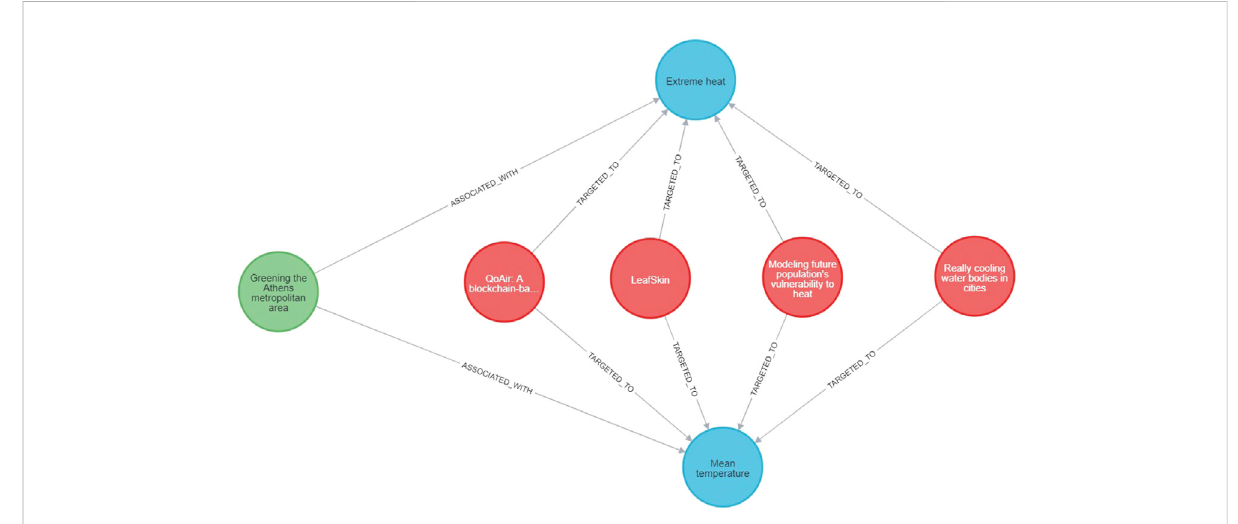
FIGURE 12 Climate hazards and innovation for a speci fi c case